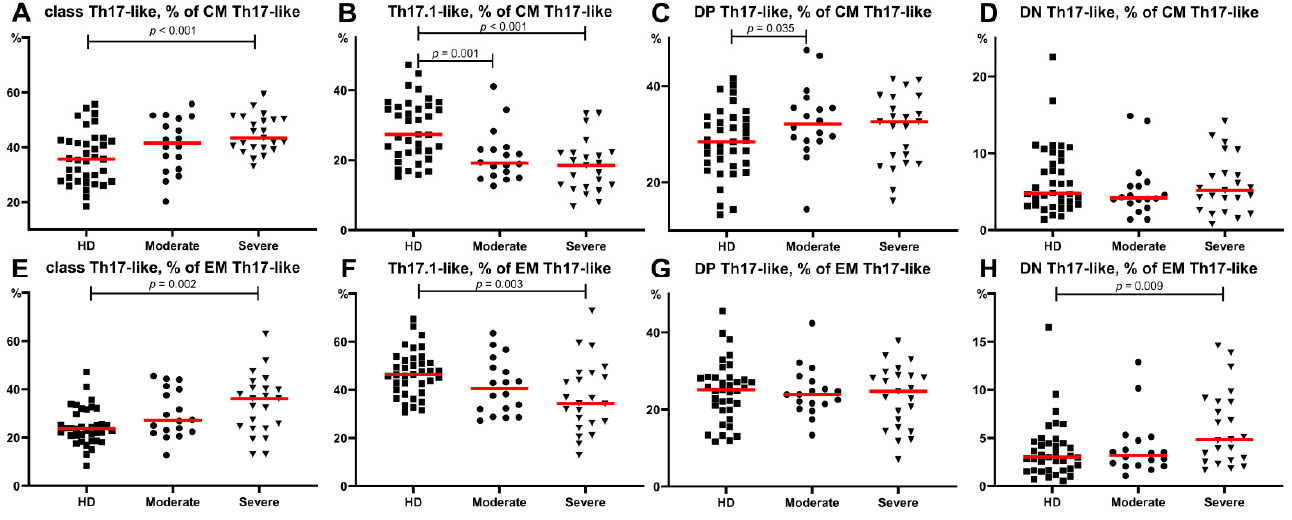
Figure 6. Th17-like cell subsets calculated from CM Th17-like ( A – H ) or EM Th17-like () cells in COVID-19 patients and in healthy donors. ( A ) Relative count of classical Th17-like cells calculated from CM Th17-like cells. ( B ) Relative count of Th17.1-like cells calculated from CM Th17-like cells. ( C ) Relative count of DP Th17-like cells calculated from CM Th17-like cells. ( D ) Relative count of DN Th17-like cells calculated from CM Th17-like cells. ( E ) Relative count of classical Th17-like cells calculated from EM Th17-like cells. ( F ) Relative count of Th17.1-like cells calculated from EM Th17-like cells. ( G ) Relative count of DP Th17-like cells calculated from EM Th17-like cells. ( H ) Relative count of DN Th17-like cells calculated from EM Th17-like cells. DP, double positive Th17-like (expressing CXCR3 and CCR4); DN, double negative Th17-like (lacking CXCR3 and CCR4). Red lines demonstrate Median value.